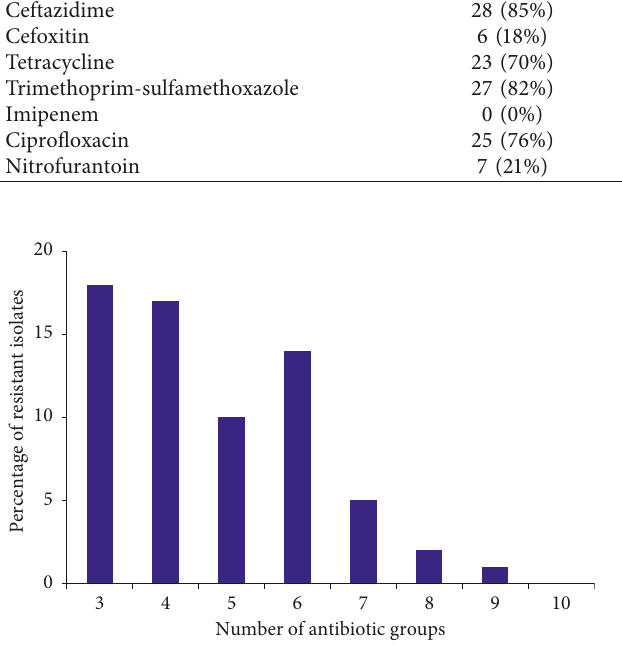
Figure 1: Percentage of clinical E. coli urine isolates showing multidrug resistance (MDR) phenotype.